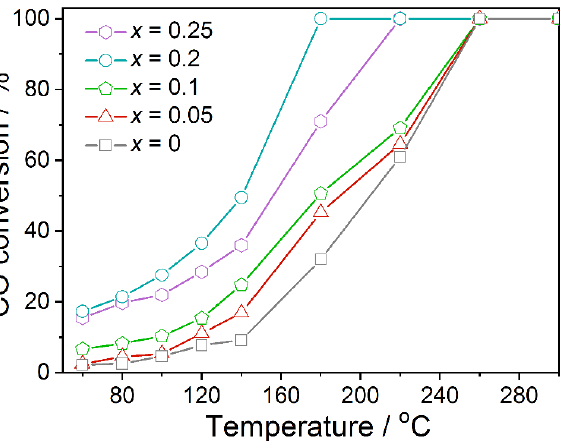
Figure 1. CO conversions obtained from the La 1- x Ce x MnO 3 (0 ≤ x ≤ 0.25) catalysts as a function of reaction temperature. Table 1. Comparison of BET surface area and CO conversion with other reported